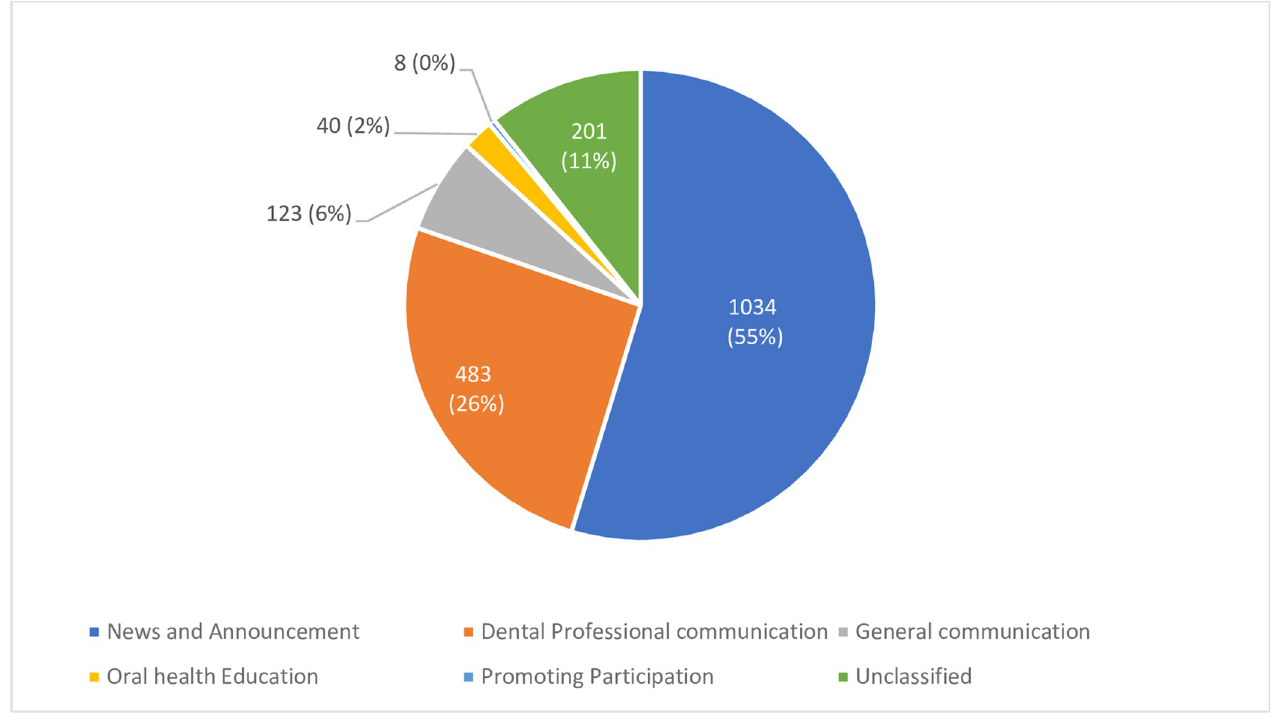
Fig 3. Thematic distribution of tweets for all dental schools.